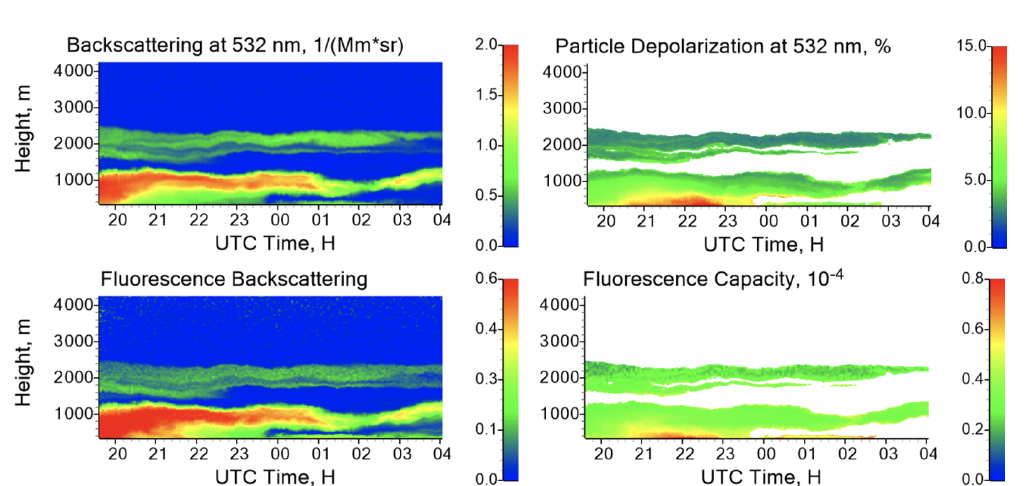
Figure 11. Spatiotemporal distributions of the backscattering coefficient β 532 , the fluorescence backscattering coefficient β F (in 10 − 4 Mm − 1 sr − 1 ), the particle depolarization ratio δ 532 , and the fluorescence capacity G F on the night of 10–11 April 2020. Measure- ments are performed at an angle of 45 ◦ to the horizon. The values of δ 532 and G F are shown for β 532 > 0.2Mm − 1 sr − 1